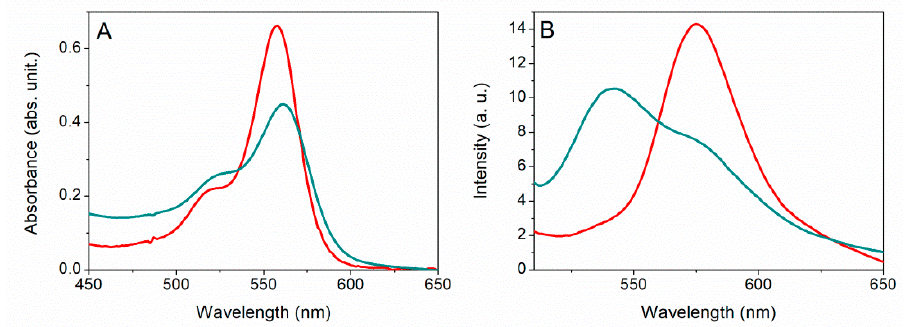
Figure 1. UV / Vis spectra ( A ) and steady steady state emission spectra ( B ) of free Ada-Rhod in DCM (red trace) and PolyCD@Ada-Rhod (blue cyan trace) in ultrapure water, pH = 4. ( A ): 44 mg / mL, [Ada-Rhod] = 713 µ M, pH = 4, d = 1 cm and scattering subtracted in the spectrum of the PolyCD@Ada-Rhod. ( B ): 0.5 mg / mL, [Ada-Rhod] = 8 µ M, λ exc = 480 nm.